Question: Produce a descriptive caption suitable for publication.
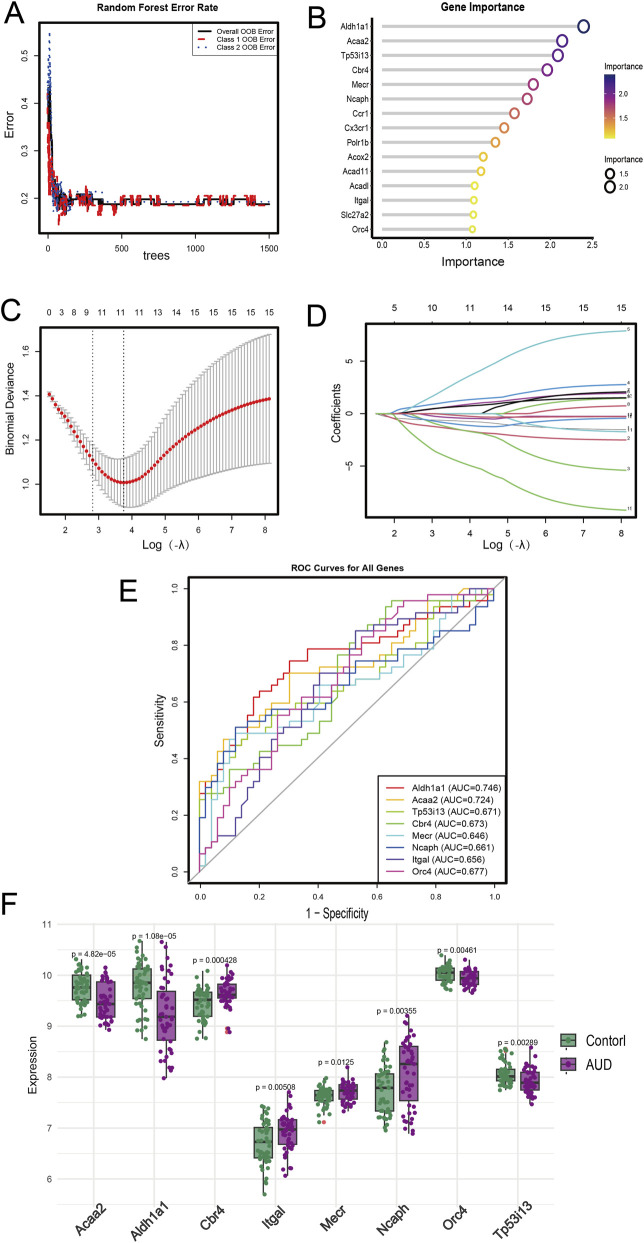
Answer: Identification of key genes associated with AUD. (A,B) Top 15 genes identified from hub genes using the random forest (RF) algorithm based on importance ranking. (C,D) Eight key genes with Non-zero coefficients identified from the 15 genes via LASSO regression (λ = 3.31). (E) Receiver operating characteristic (ROC) curves of the eight key genes, all with AUC > 0.65, indicating good diagnostic efficacy for AUD. (F) Boxplots of the eight key genes based on unpaired t-tests.